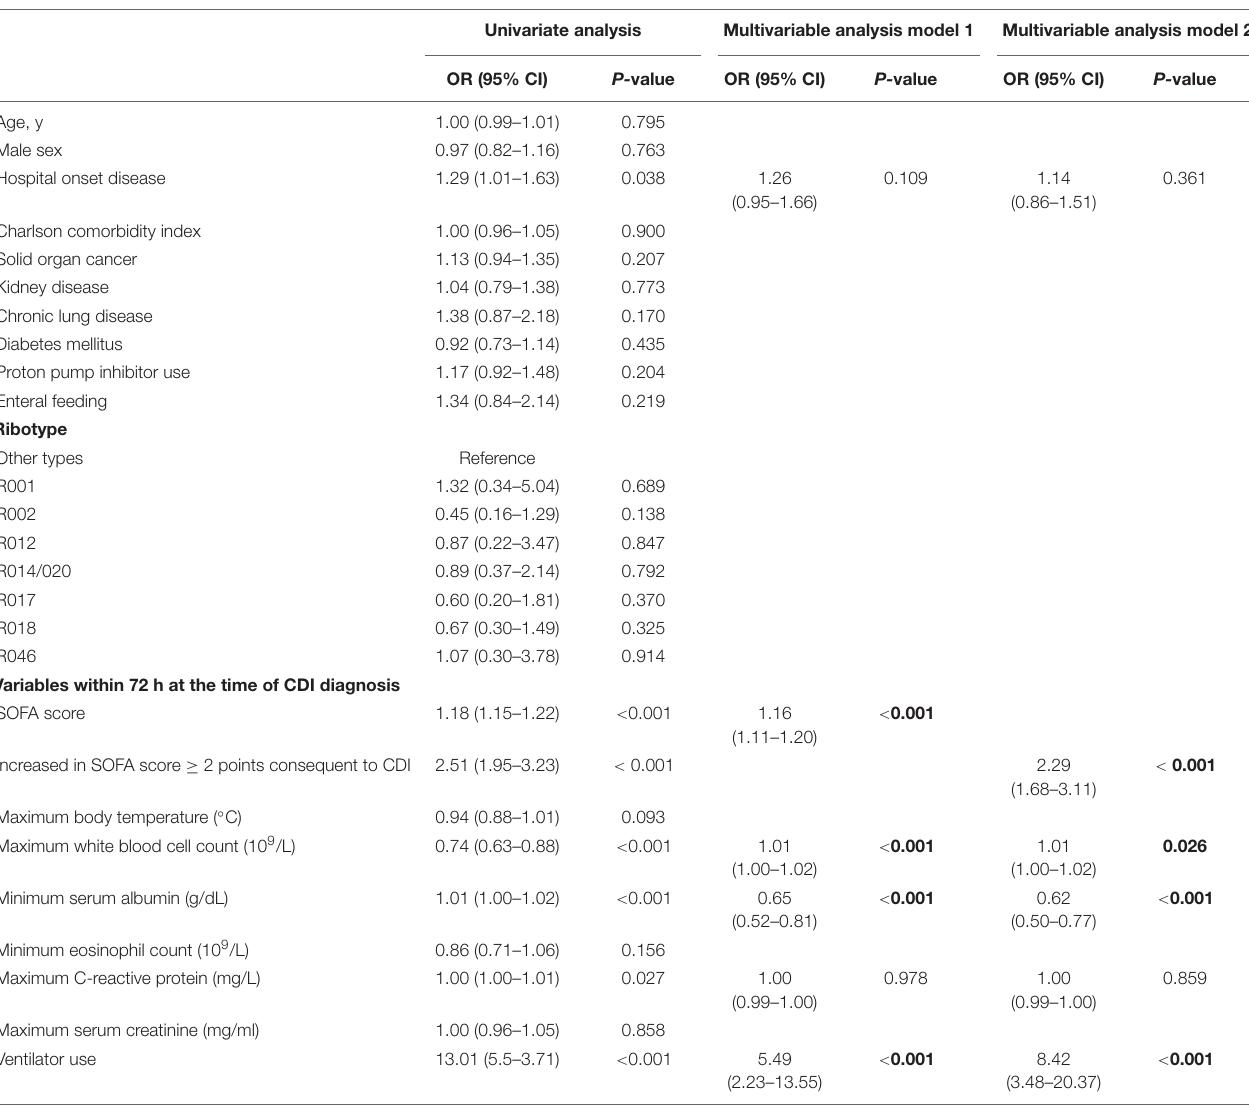
TABLE 3 | Univariate and multivariate analysis using conditional logistic regression of risk factors of severe CDI, after propensity-score matching.